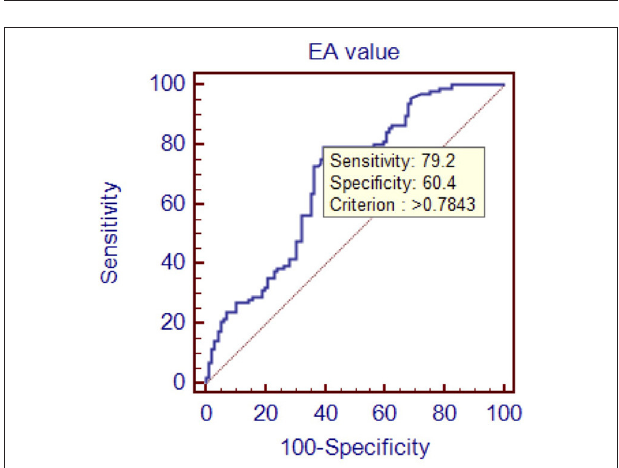
FIGURE 3 | Receiver operating characteristic curve of E/A value to diagnose HFPEF. Area under the curve: 0.688, 95% C.I. (0.618–0.753), P < 0.0001.